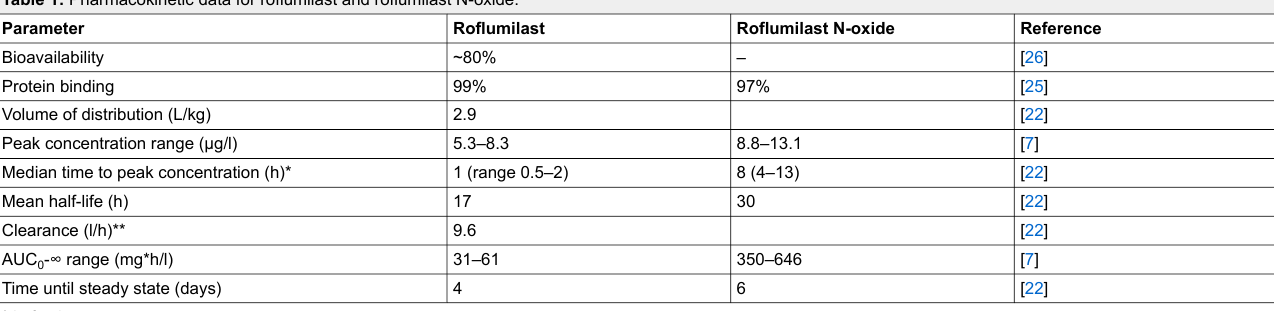
Table 1: Pharmacokinetic data for roflumilast and roflumilast N-oxide.